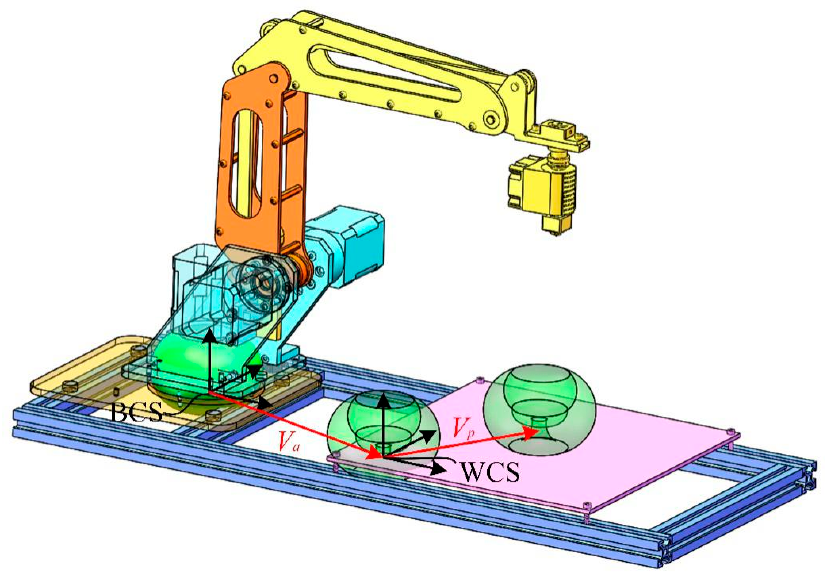
Figure 14. The scaling and the translating of the workspace model for 3D printing.